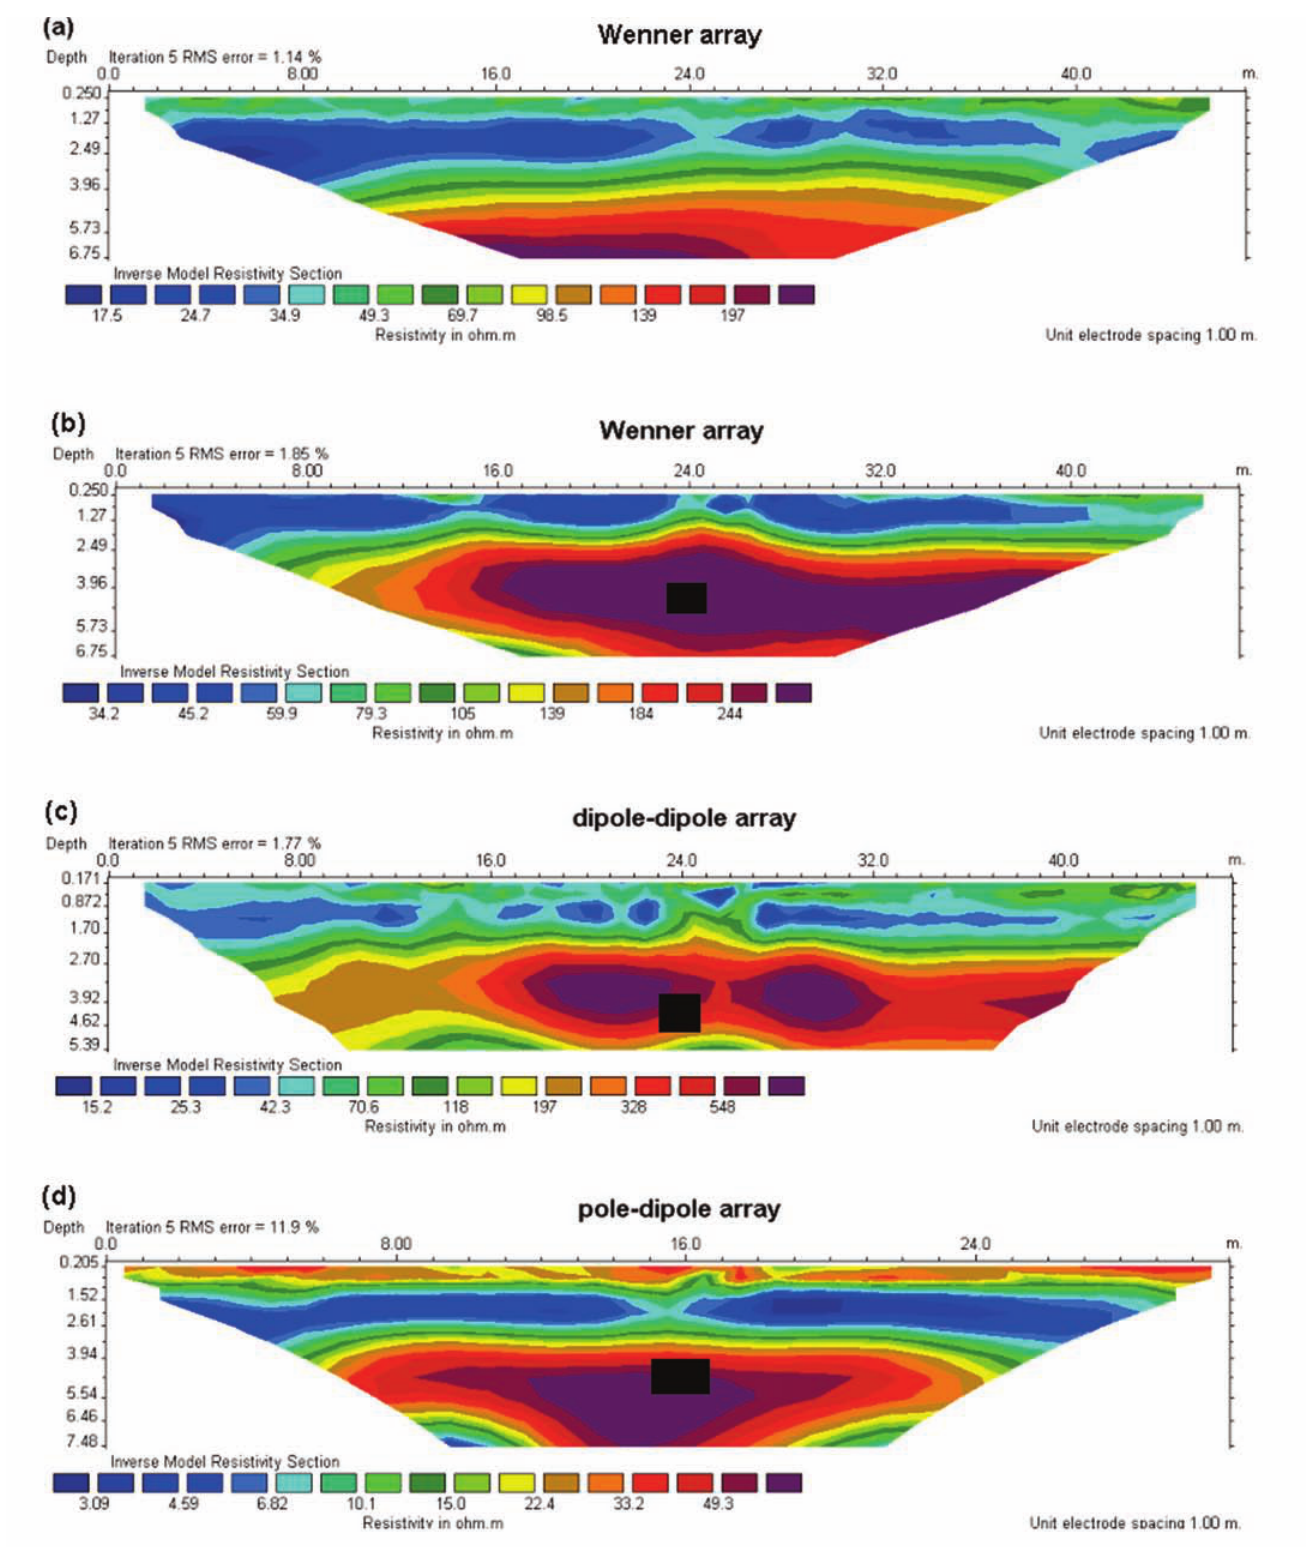
Figure 3. Electrical resistivity tomography profiles of the nearby terrain (a) and the test site for the Wenner (b), dipole-dipole (c) and pole-dipole (d) arrays. The lateral section of the steel-drum arrangement is also shown